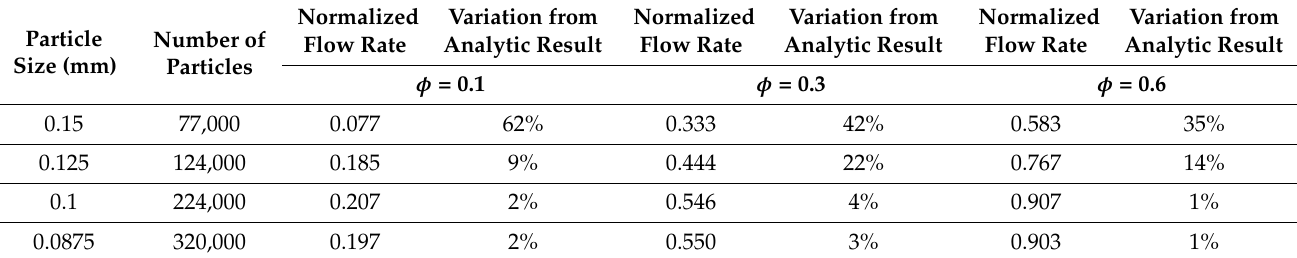
Table 4. Effect of particle size in the SPH simulations.